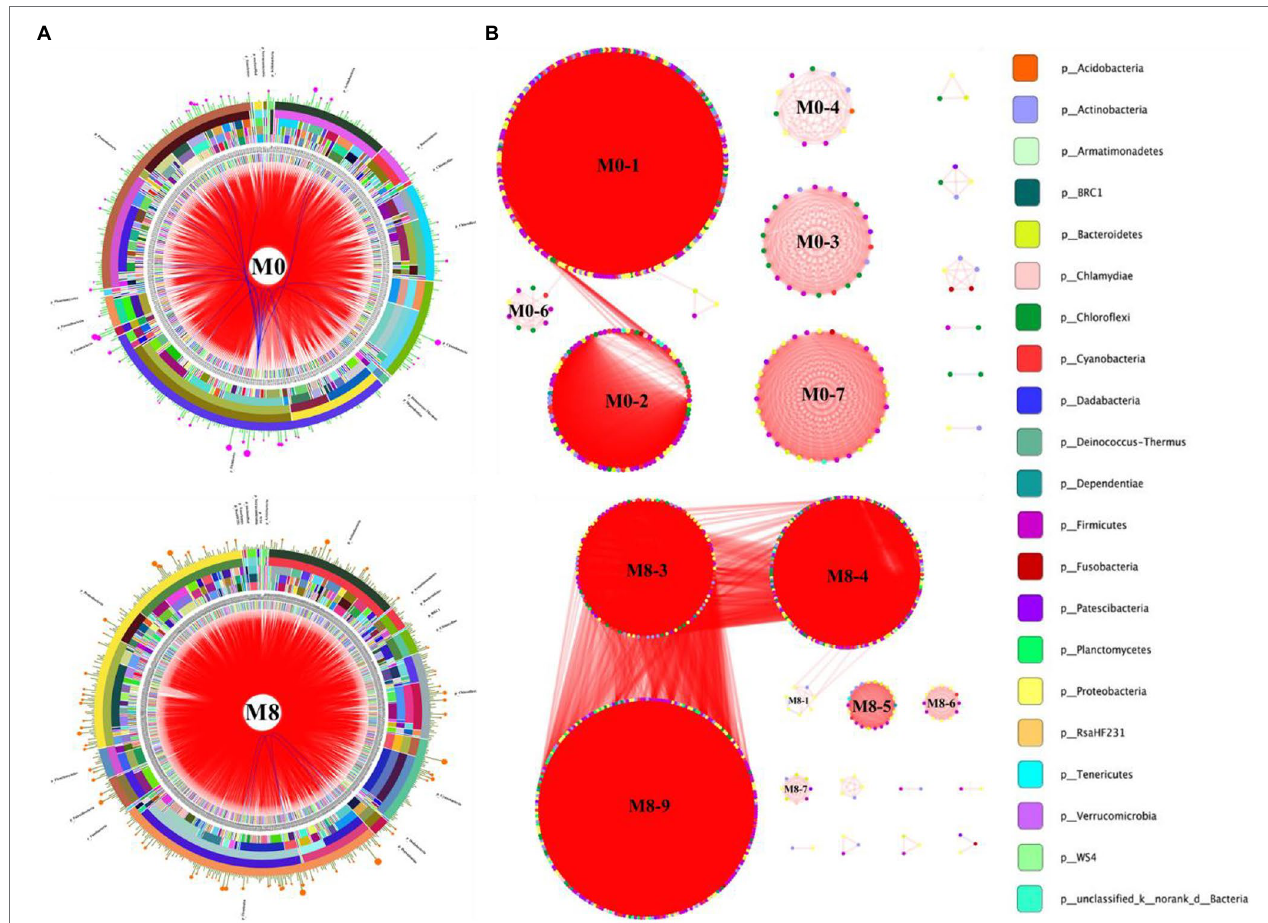
FIGURE 3 | Circos plots (A) showing the assignment of OTUs at different taxonomic levels of classification. Ecological network (B) showing the submodules and interspecific interactions in the gut bacterial community of M. albus . The data were analyzed using the R Programming Language. The taxonomic levels were phylum, class, order, family, and genus, moving from the outside to the inside of the circle, respectively. Bands differing in color show different genera, and the bar width indicates the abundance of each taxon in the circos plot. The modular organization was constructed by implementing the modularity optimization method. Each node in the network graph corresponds to a single OTU. Colors of the nodes indicate different major phyla. The edges inside the circle and ecological network represent the interactions between species (pink edge, positive interaction; blue and red edges, negative